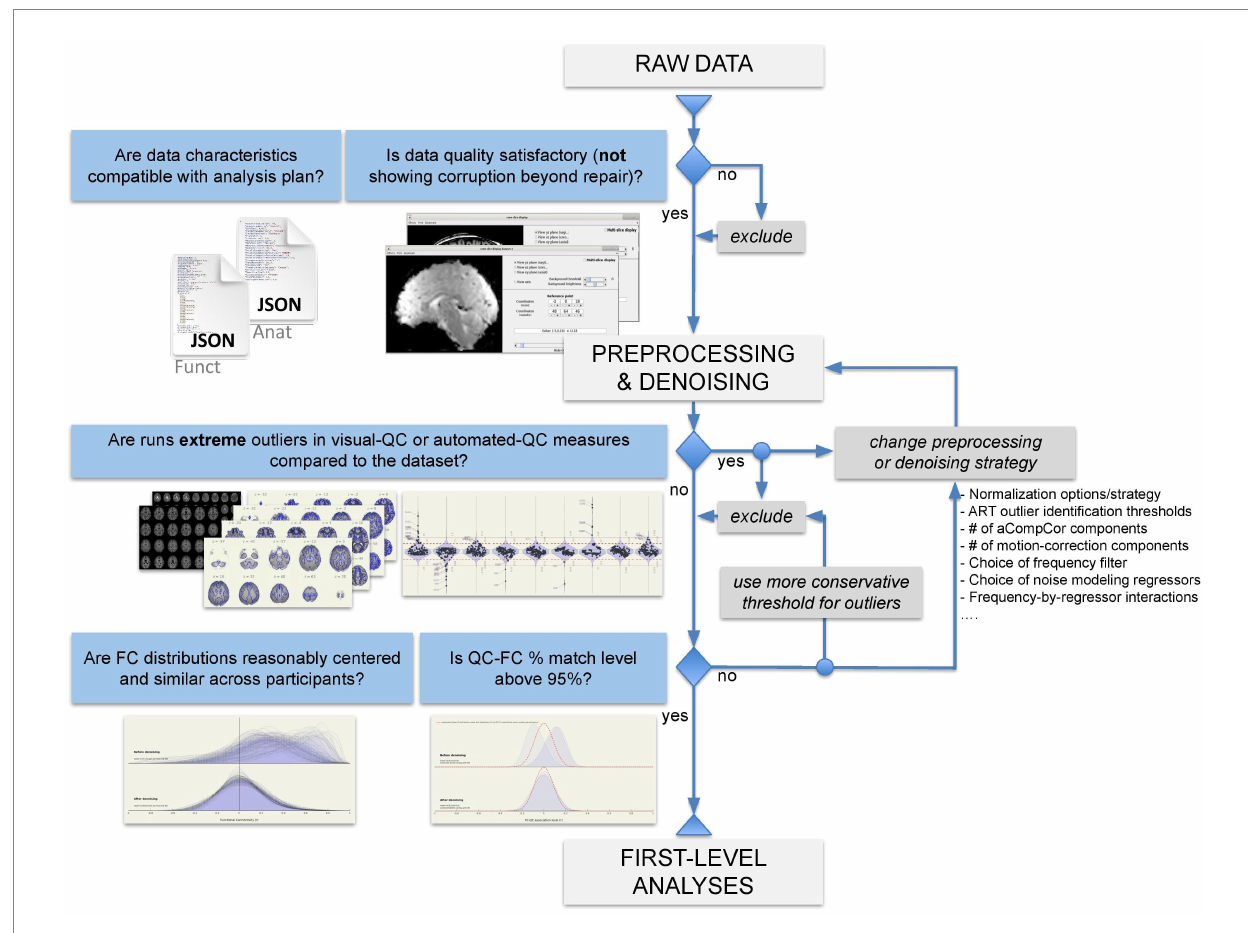
FIGURE 2 Flowchart of quality control